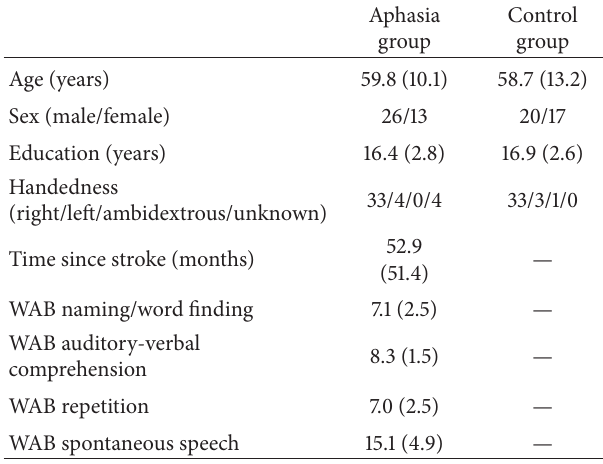
Table 1: Demographic information for the aphasia group and control group. Standard deviations are shown in parentheses. There were no differences between the groups on age, sex, education, or